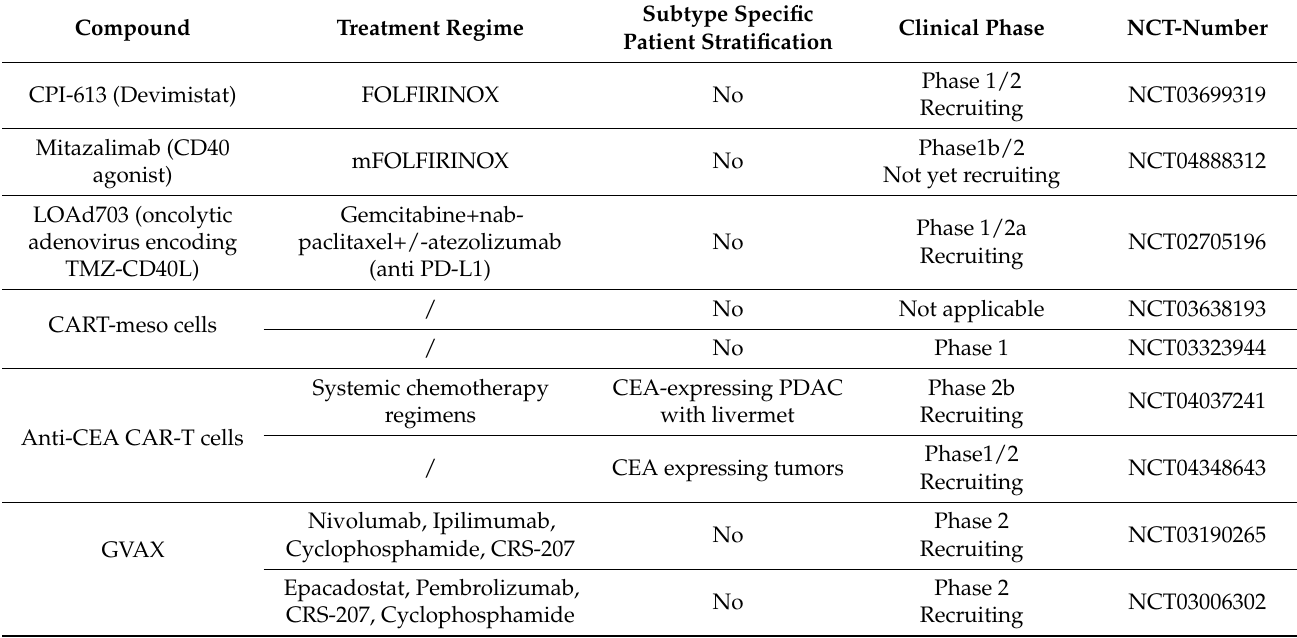
Table 2. Current ongoing clinical trials evaluating the efficacy of promising compounds for treatment of pancreatic cancer.